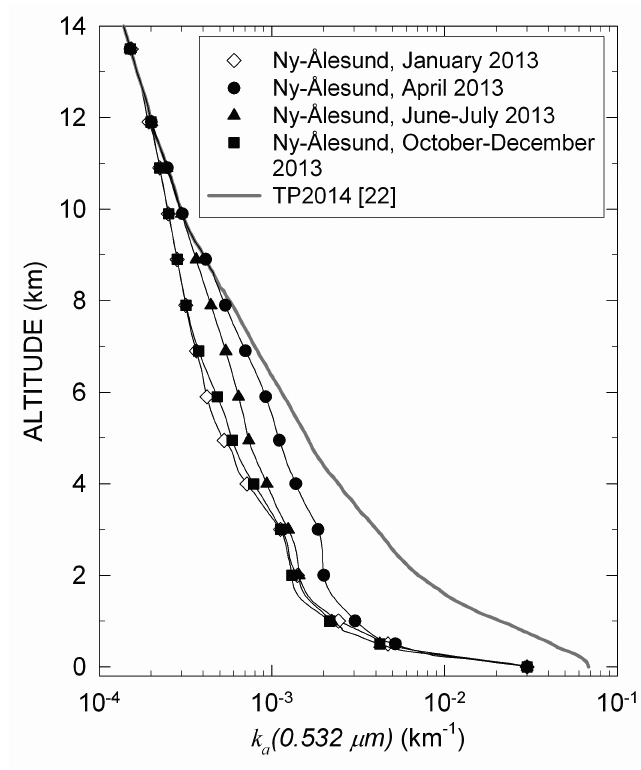
Figure 2. Monthly or multi-monthly average vertical profiles of aerosol volume extinction coefficient k a ( 0.532  m ) determined from the corresponding monthly or multi-monthly average vertical profiles of aerosol volume backscatter coefficient B bs ( 0.532  m